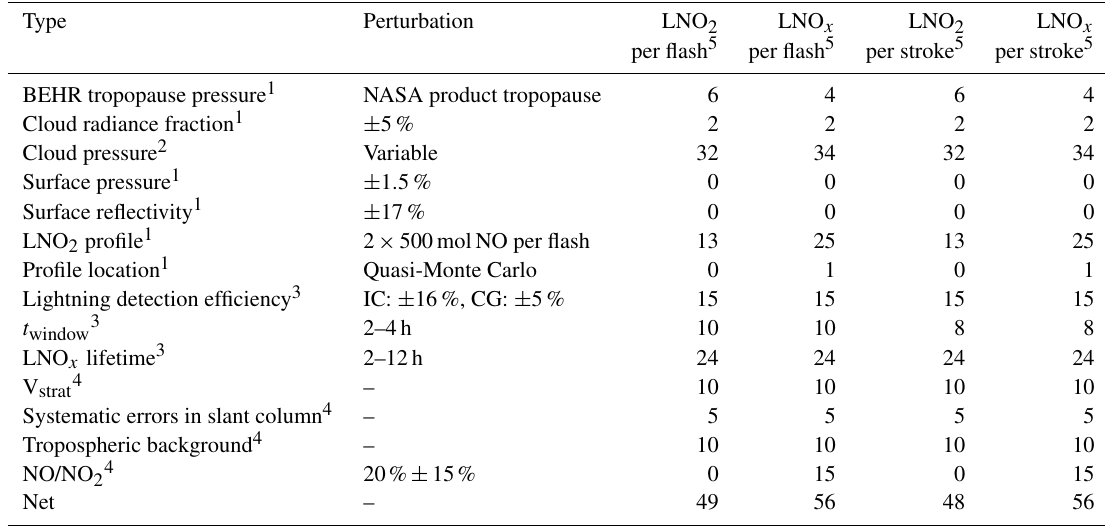
Figure 10. Average percent differences in (a) AMF LNO Differences between profiles are generated by 2 × 500 and 1 × 200molNO per flash. Table 5. Uncertainties for the estimation of LNO 2 per flash, LNO x per flash, LNO 2 per stroke, and LNO x per stroke.